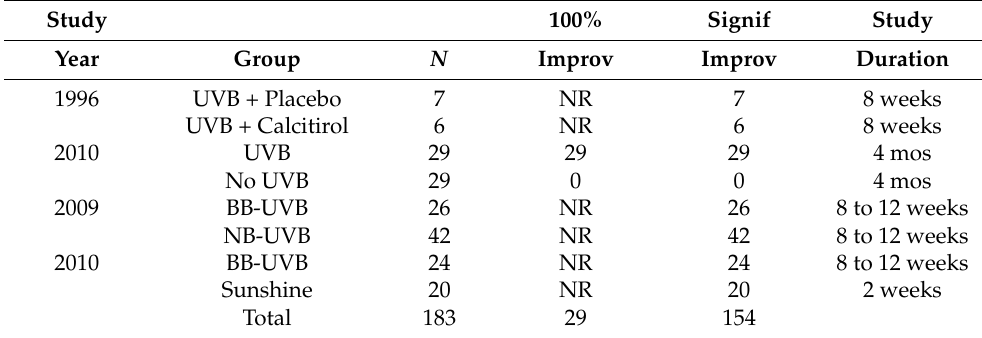
Table 3. Study year, type of phototherapy of used in each study, number of patients treated, study duration and number of patients showing significant improvement following treatment. Study 100% Signif Study Year Group N Improv